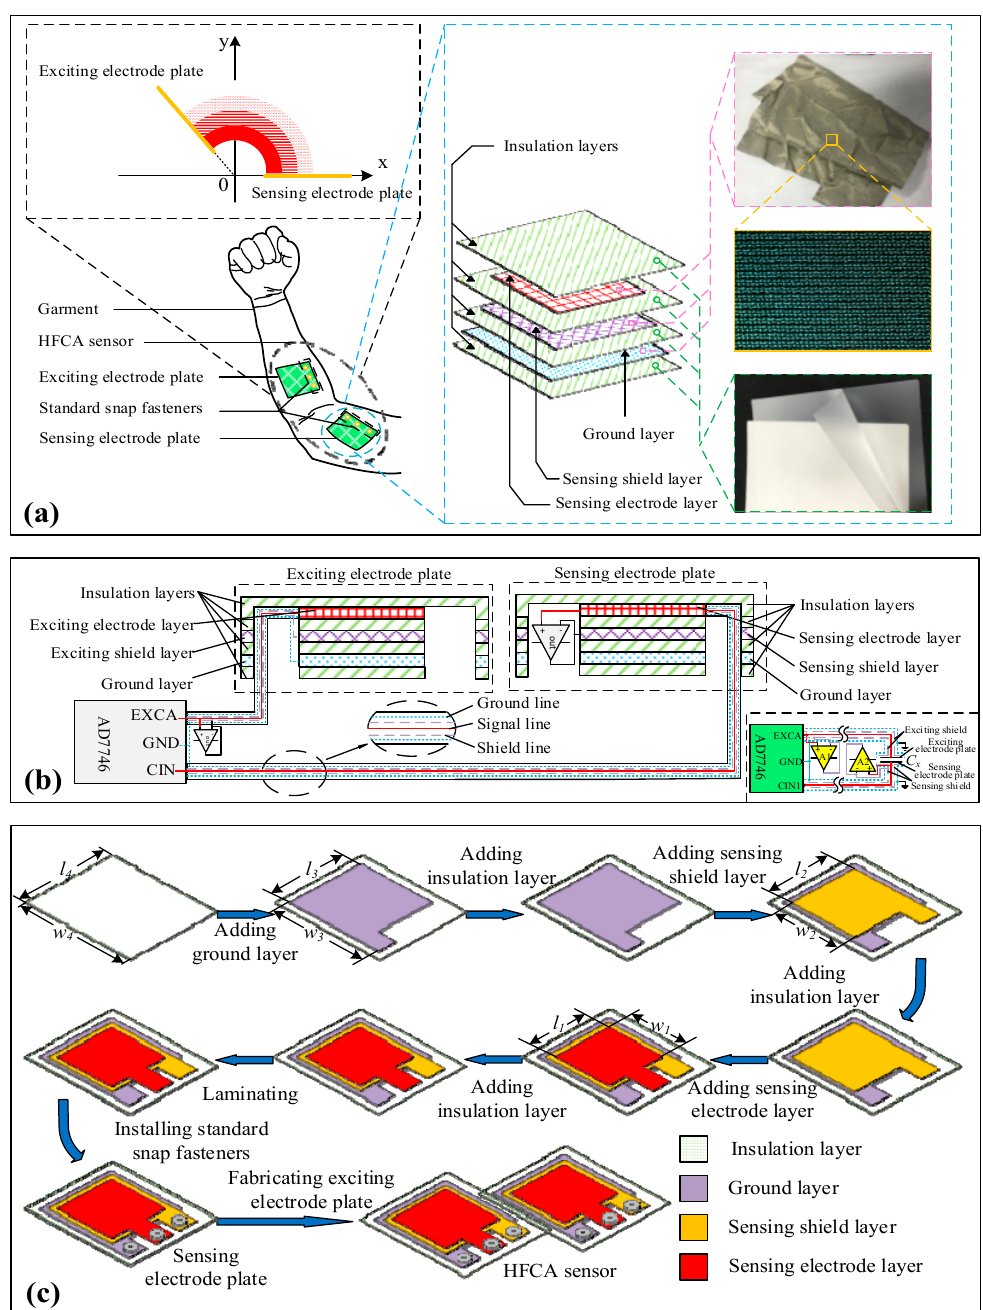
Figure 2. Fabrication of the NFCAS. ( a ) Schematic illustration of the NFCAS. Inserts: diagrams of the NFCAS’s model and structure, and images of the main materials of the NFCAS; ( b ) Circuit connection schematic of the NFCAS; ( c ) Fabrication process schematic for the NFCAS.